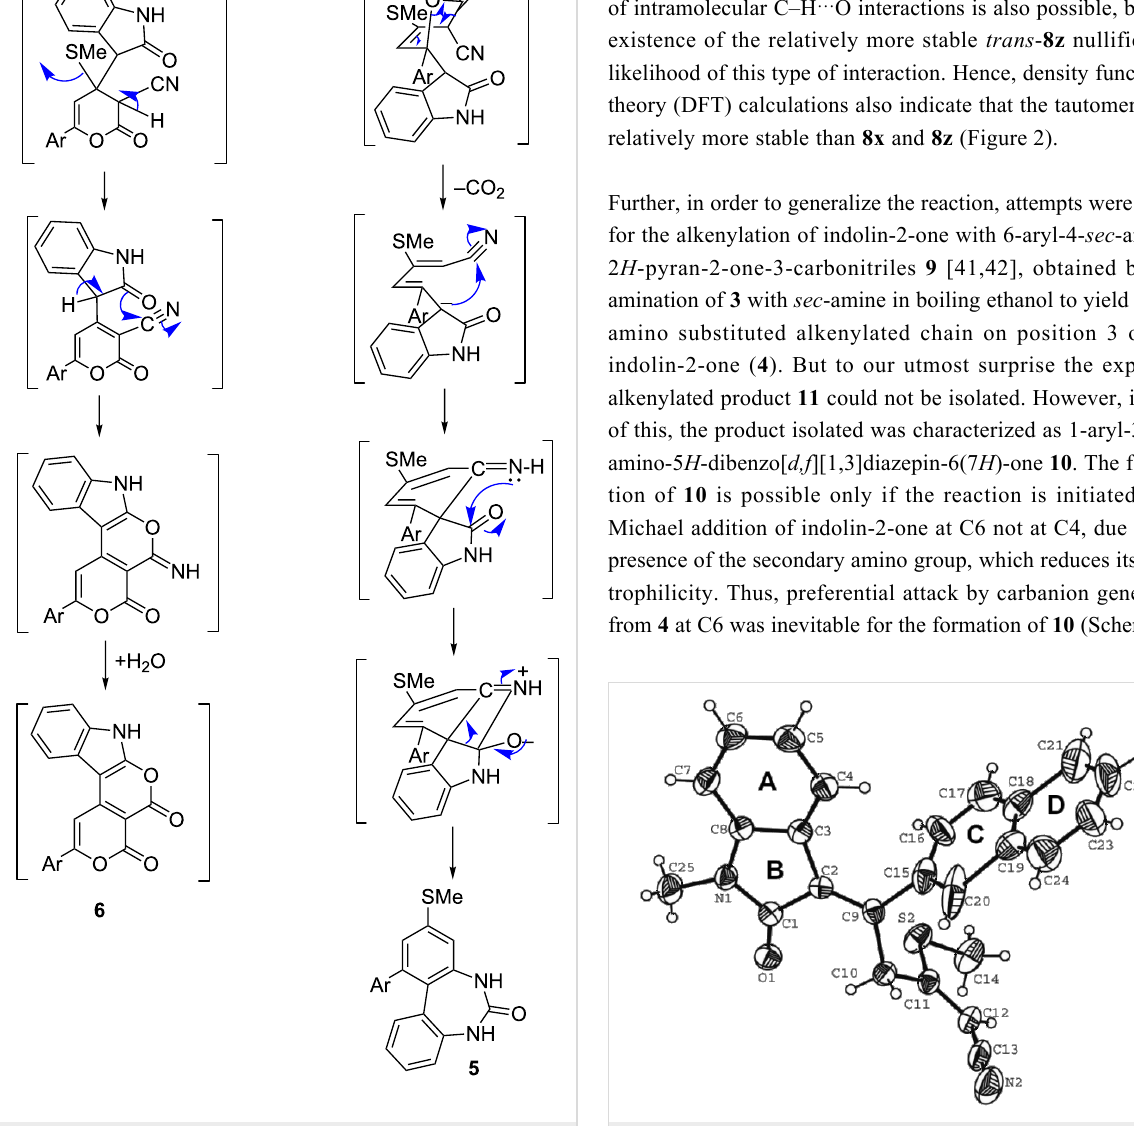
Figure 2: ORTEP view with atom numbering scheme of compound 8yc with displacement ellipsoids at the 30% probability